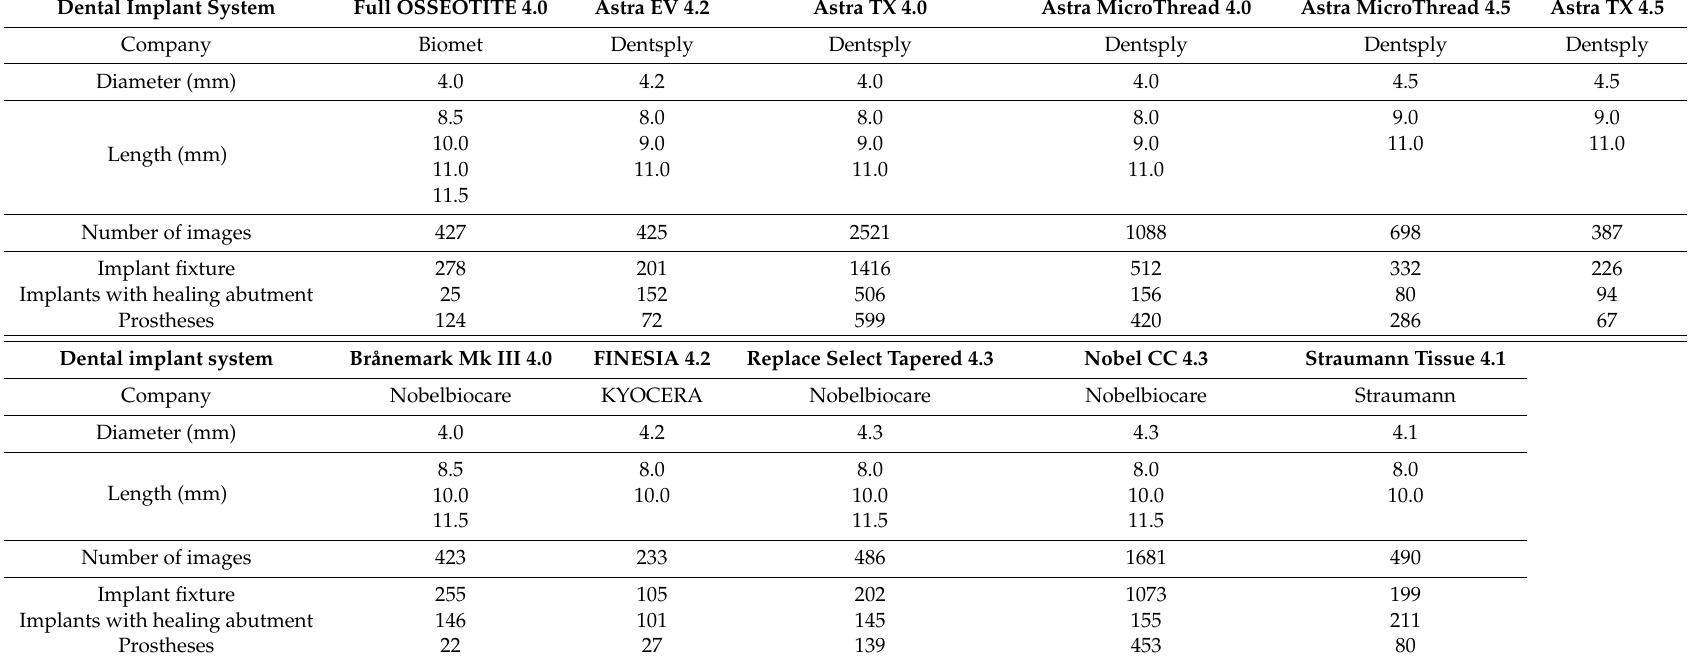
Table 1. Types of dental implant systems and corresponding number of